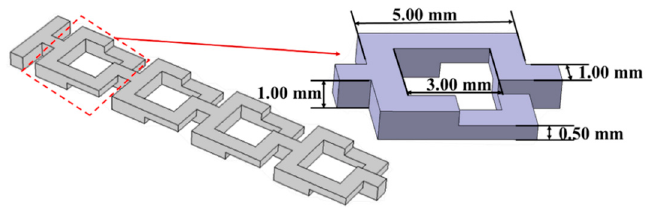
Figure 3. Geometric model of flow channel constructed by chaotic Baker map.